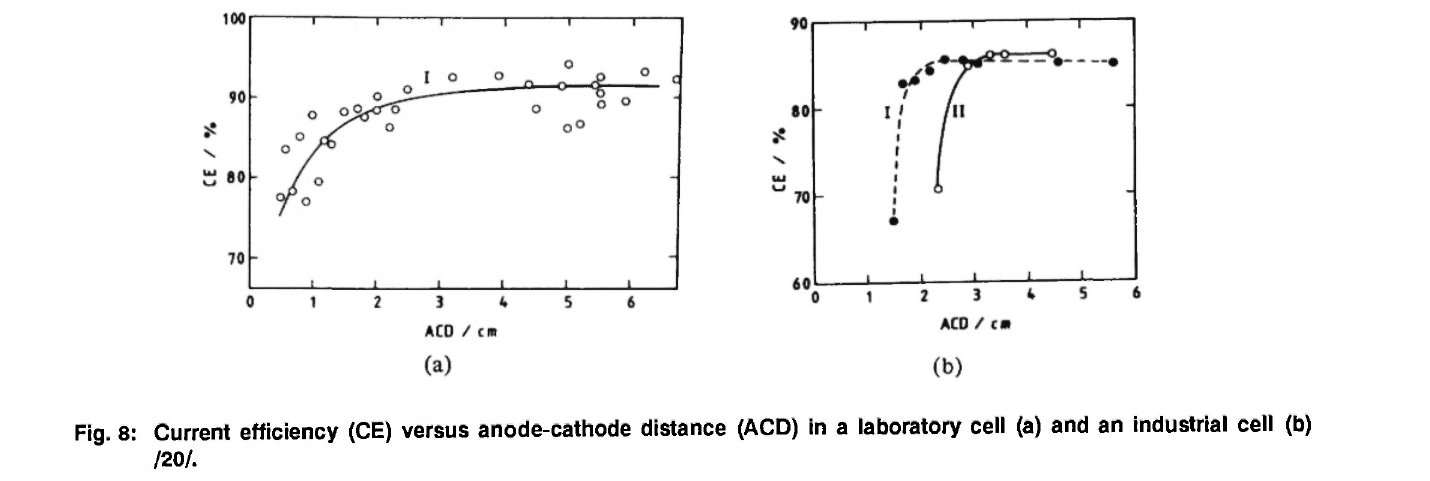
Fig. 8: Current efficiency (CE) versus anode-cathode distance (ACD) in a laboratory cell (a) and an industrial cell (b)